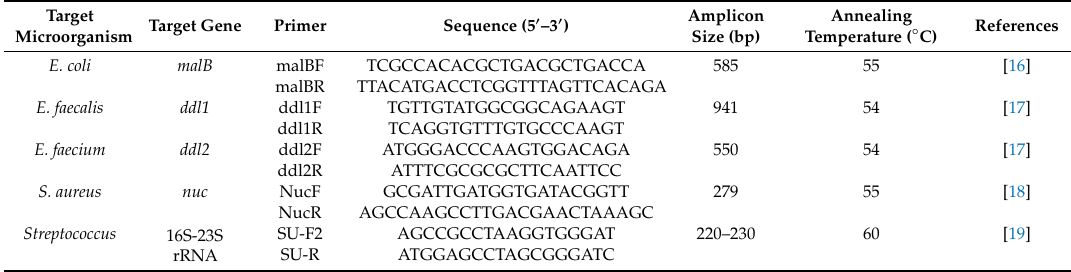
Table 1. PCR primers used in this